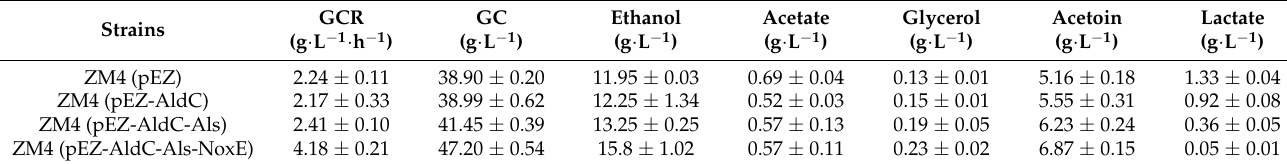
Figure 3. Strategy and result of metabolic engineering of Z. mobilis ZM4 for acetoin production. ( A ) Three plasmids designed for the acetoin pathway genes were tested in Z. mobilis . Pgap , a native promoter of Z. mobilis ; EcaldC , aldC from E. cloacae , Blals , als gene from B. licheniformis . ( B ) Schematic of heterogenous acetoin biosynthetic pathway. ( C ) Metabolites produced by different recombinant strains of Z. mobilis containing different combinations of heterologous genes. Values are the means of experiments with three or more technical replicates; error bars are standard deviations. Table 3. Fermentation profiles of recombinant Z. mobilis strains containing different gene(s) for acetoin biosynthesis. GCR: Glucose consumption rate, GC: Glucose consumed. Strains were cultured in 100-mL shake flakes with 20 mL medium at 30 ◦ C, 100 rpm. Mean values for triplicate repeats are shown for each condition ± standard